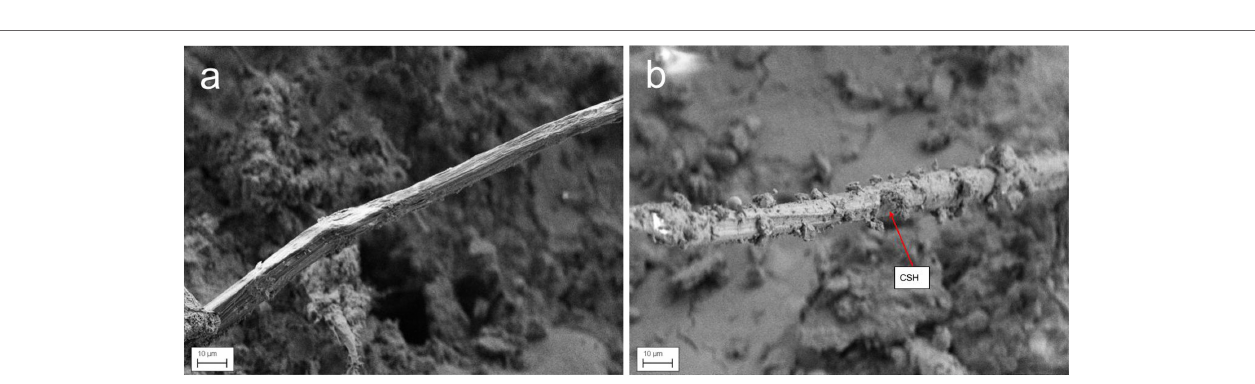
Frontiers in Built Environment |